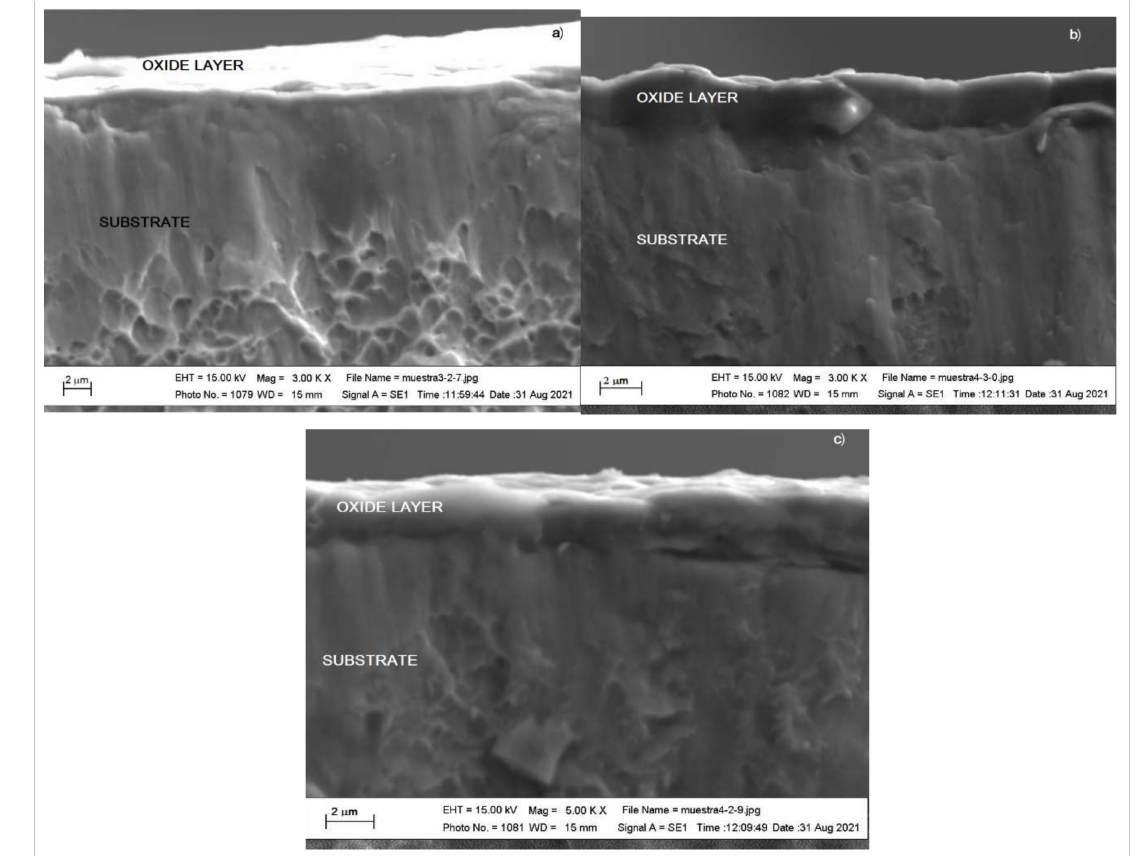
Figure 1. SEM micrographs of Ti6Al4V alloy oxidized during ( a ) 1, ( b ) 3, and ( c ) 8